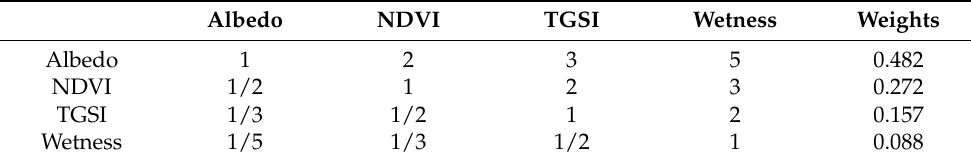
Table 3. Index comparison